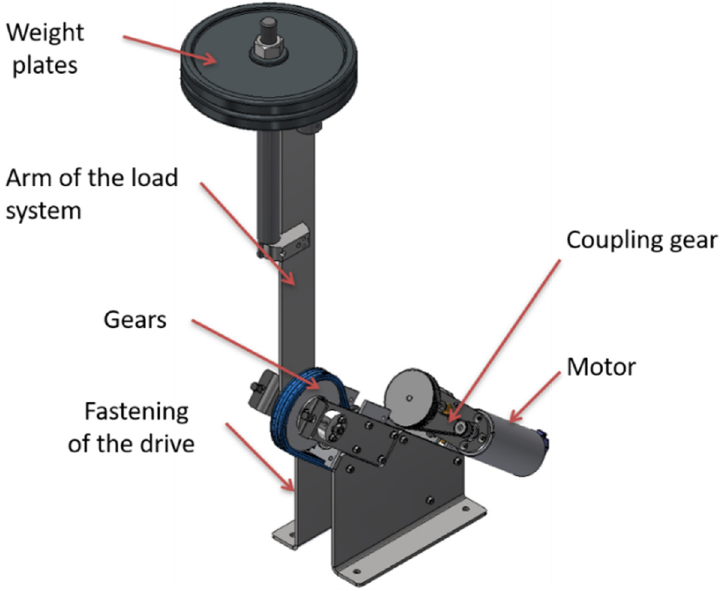
Figure 21. View of the developed mechanical subsystem.